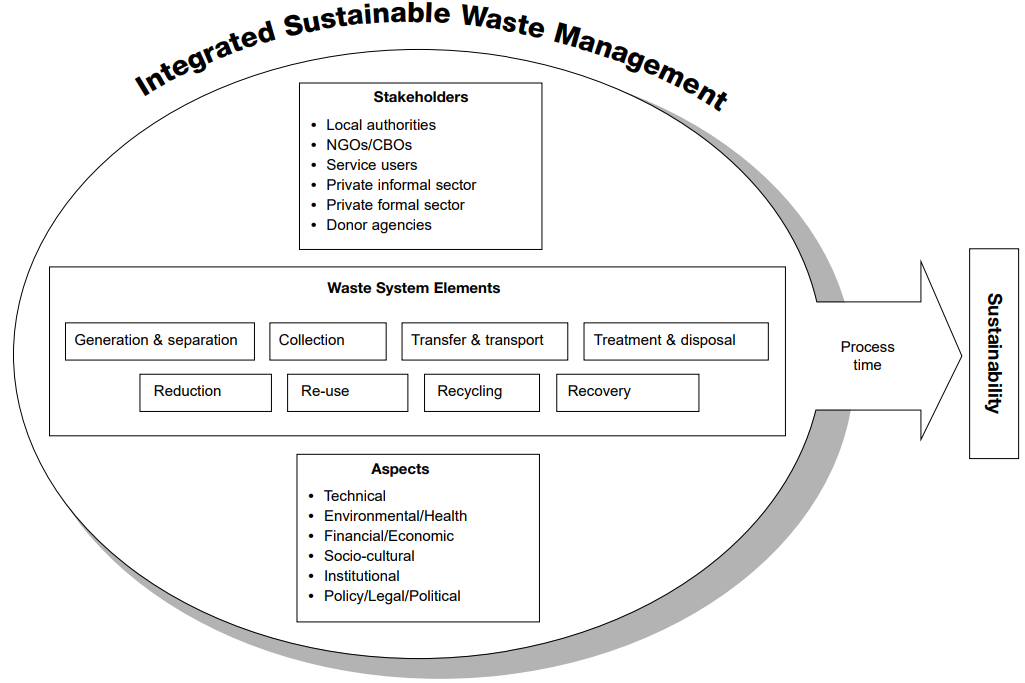
Figure 2. Integrated Sustainable Waste Management model (Source: Putting Integrated Sustainable Waste Management into Practice, 2004) [31].